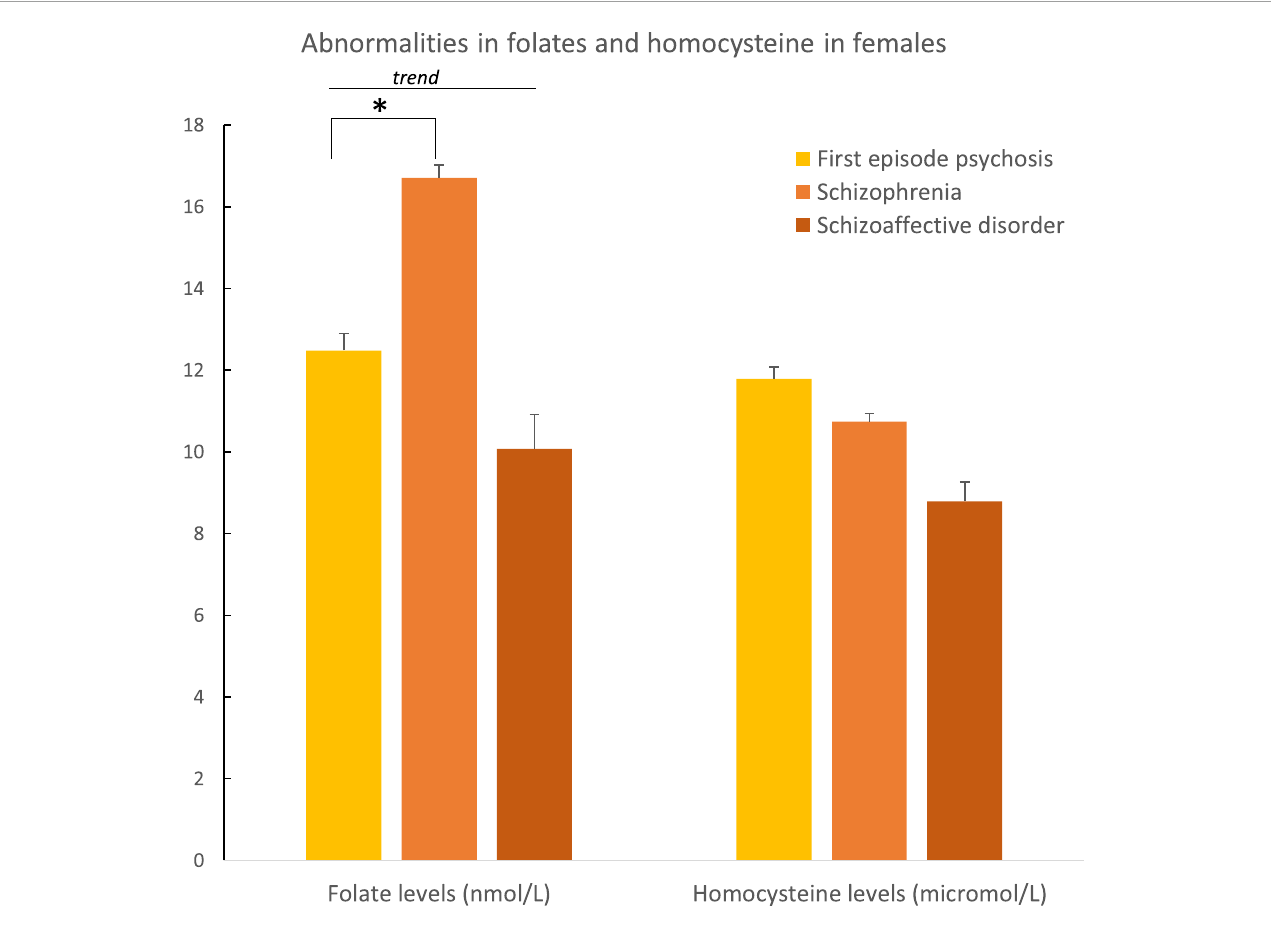
FIGURE5 Abnormalities in folate and homocysteine in females according to psychosis spectrum diagnoses. Differences in folate levels were observed between female patients with a first episode of psychosis and female patients with schizophrenia ( p = 0.05). * p ≤ 0.05.